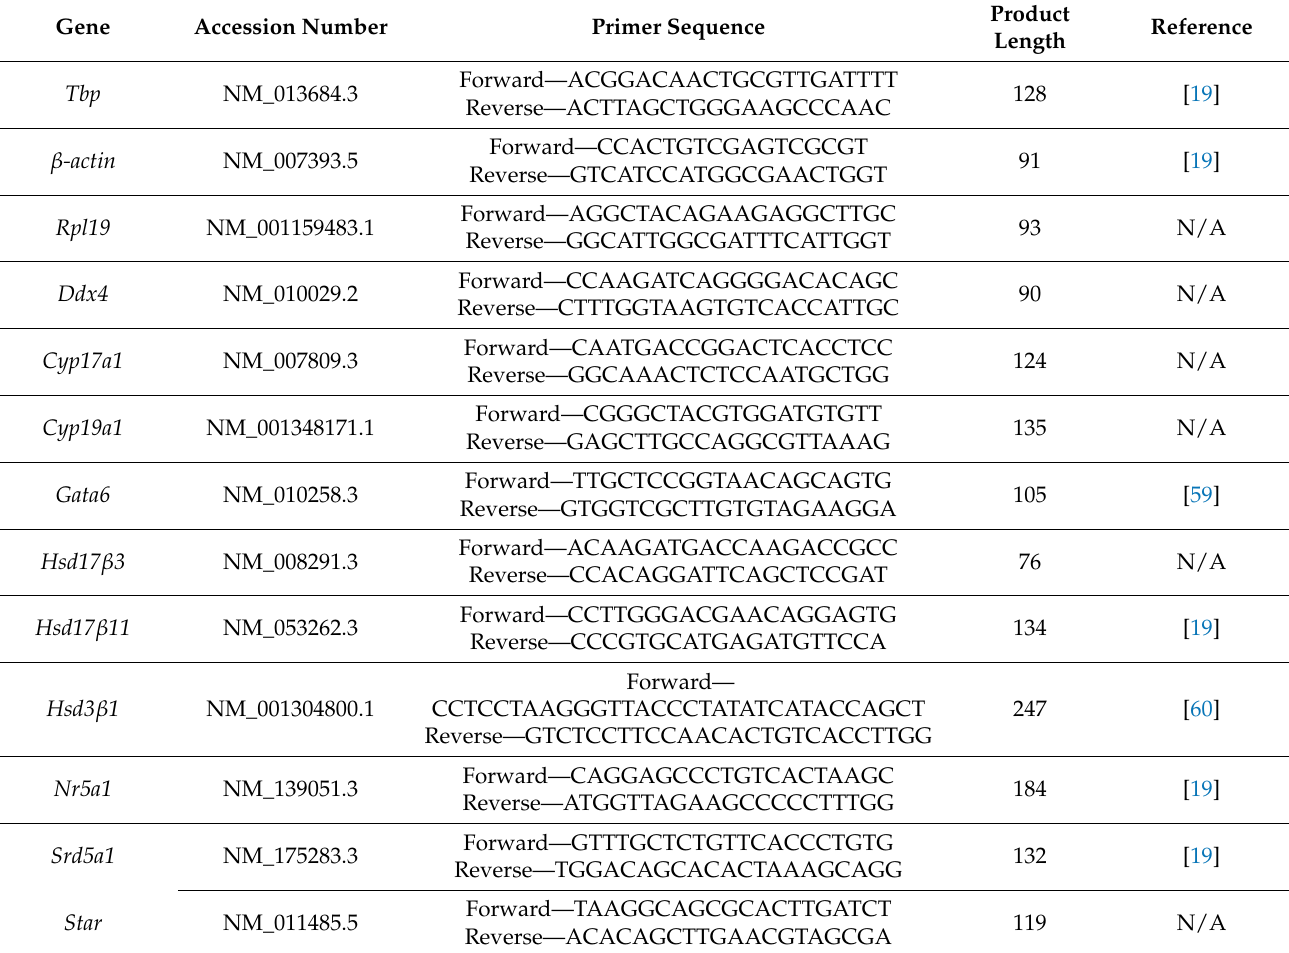
Table A1. Primer used in qRT-PCR